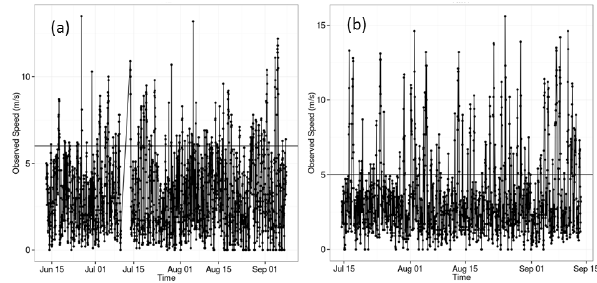
Figure 4. Observed hourly wind speeds for (a) sensor R2 at Big Southern Butte and (b) NM1 at the Salmon River Canyon study site. The horizontal line indicates the threshold speed chosen to partition synoptically driven events from diurnal